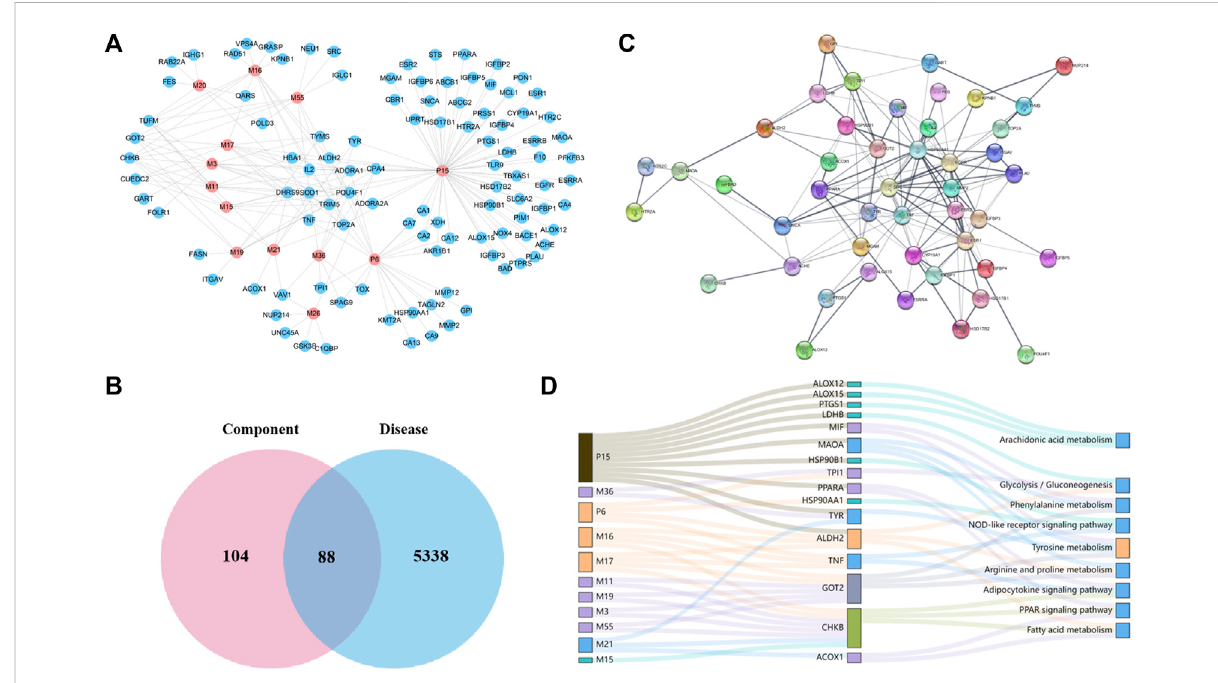
Network construction and correlation analysis. (A) Distribution characteristic of 13 candidate-absorbed components and their predicted targets; (B) Venn analysis of targets between 13 candidate components and ALD; (C) PPI network of 47 merged targets according to the STRING database; (D) interaction network of absorbed constituents, candidate targets, and enriched pathways. A node stands for a constituent (left), a target (middle), or a pathway (right); the interactions of two nodes were represented by a line, and the bigger size of a node, the higher the